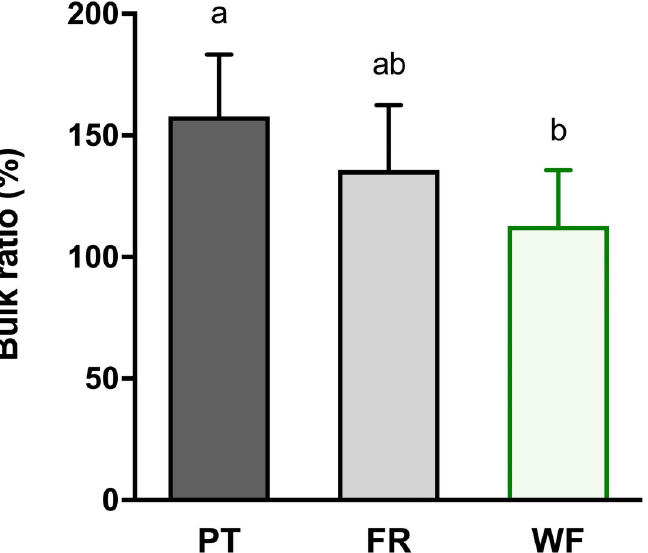
Fig 3. Effects of suture techniques Pulvertaft (PT), Fride´n (FR) and Woven-Fride´n (WF) on bulk ratio in % (ratio of the cross-sectional area of the sutured tendons and the native tendons; for details see S1 Data). Data is expressed as means, standard deviation bars are shown. Different superscripts indicate statistically significant differences among groups at p < 0.001. For each experimental group, 12 side-to-side tenorrhaphies were tested.